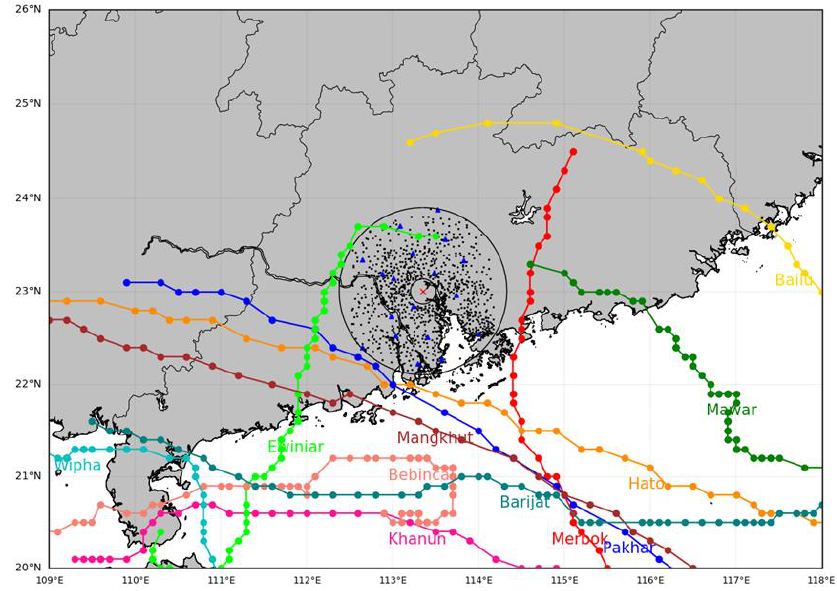
Figure 1. Tracks of the eleven landfalling typhoons and the locations of the Guangzhou radar (red cross) and automatic weather stations. The blue triangles and black dots denote the national automatic weather stations and regional automatic weather stations between the 15 km and 100 km coverage ranges (two black circles) of the Guangzhou radar. Table 1. Detailed information on the eleven typhoon precipitation events.